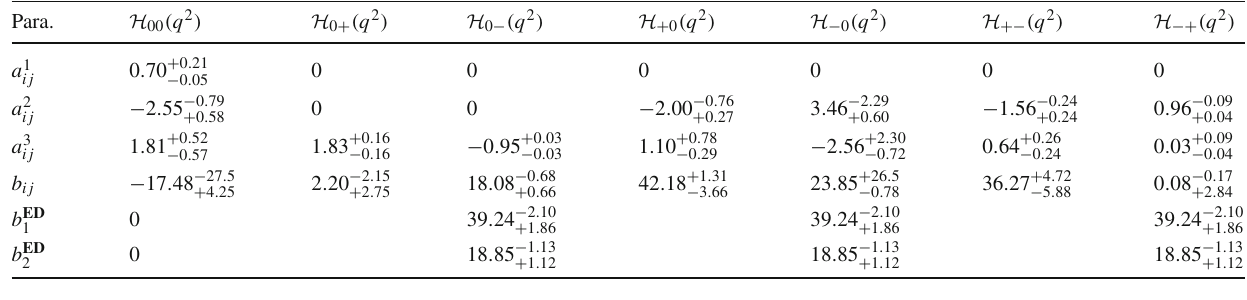
Fig. 3 The helicity form factors H ij ( q 2 ) obtained from the LCSRs calculation in the large recoiled regions and the extrapolating to the whole kinematical region by SSE